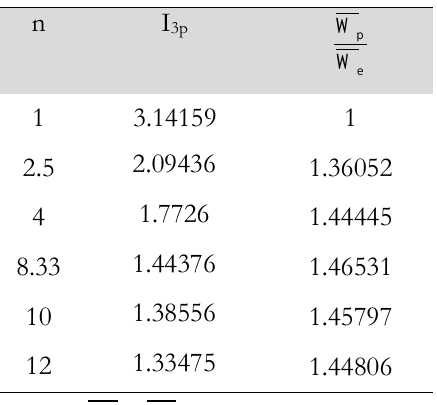
Tabella 1: Valori di I 3p